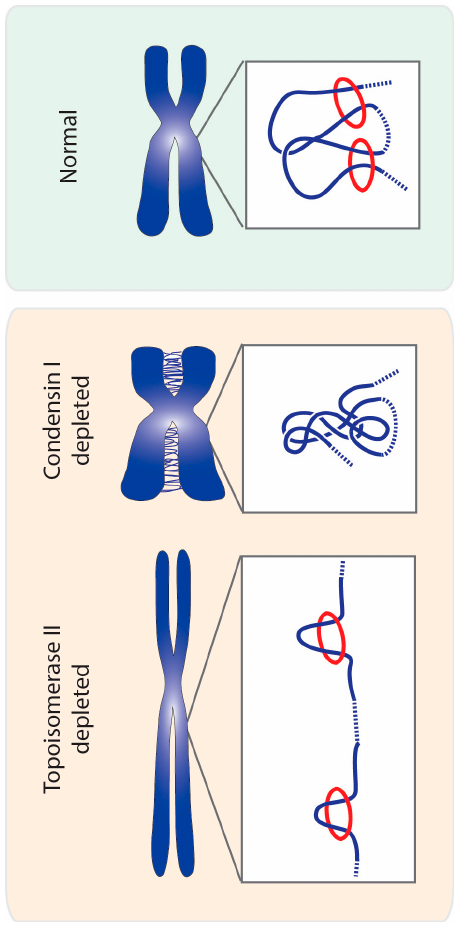
Figure 5. A topology model for chromosome compaction mediated by topoisomerase II and condensin. Proper chromosome compaction may result from a balance of self-catenation, imposed by topoisomerase II, within condensin-mediated DNA loops (condensin depicted as red circles and DNA strands in blue). Self-catenation may work as a loop-stabilizer between adjacent loops, thereby